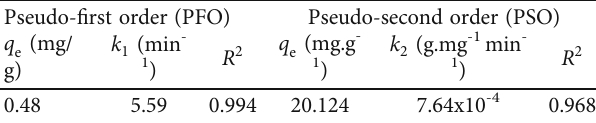
Table 15: The adsorption kinetic parameters. Pseudo- fi rst order